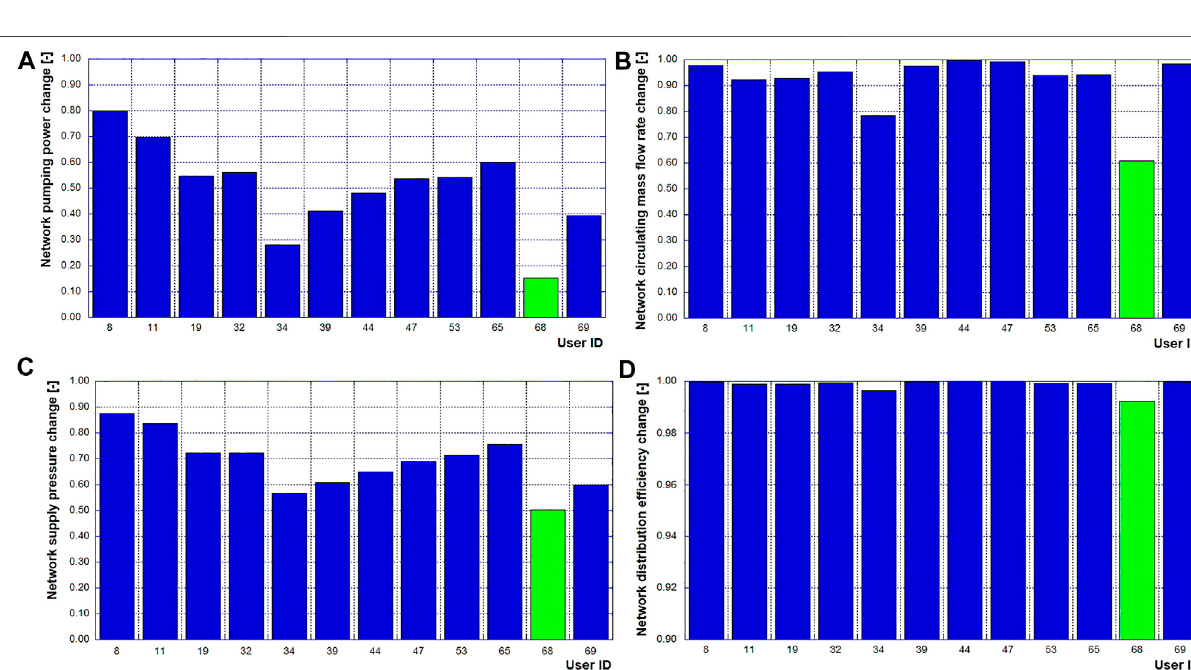
Frontiers in Mechanical Engineering |